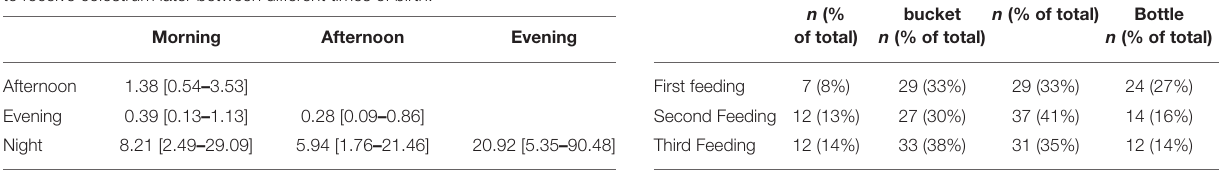
TABLE 4 | Storage methods used (if applicable) prior to first, second and third feeding of colostrum to the most recently born calf. Drank with dam Given directly n (% of after milking n (% of total)